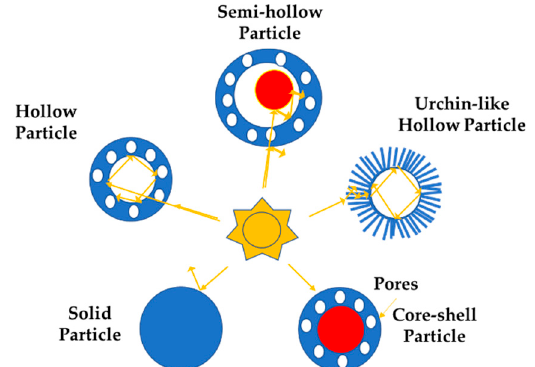
Figure 2. Schematic illustration of the light − harvesting behavior of heterogeneous photocatalysts with different nanostructures [47].